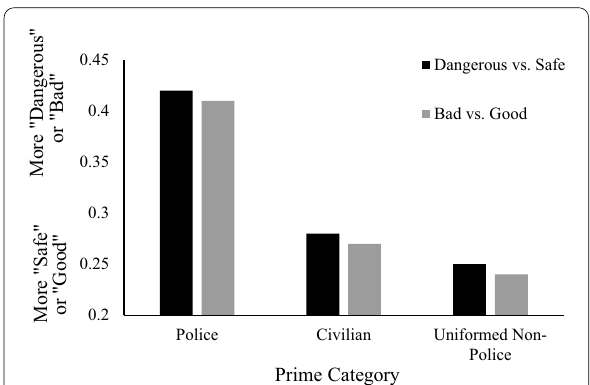
Fig. 2 Mean dangerous versus safe and good versus bad evaluations by prime